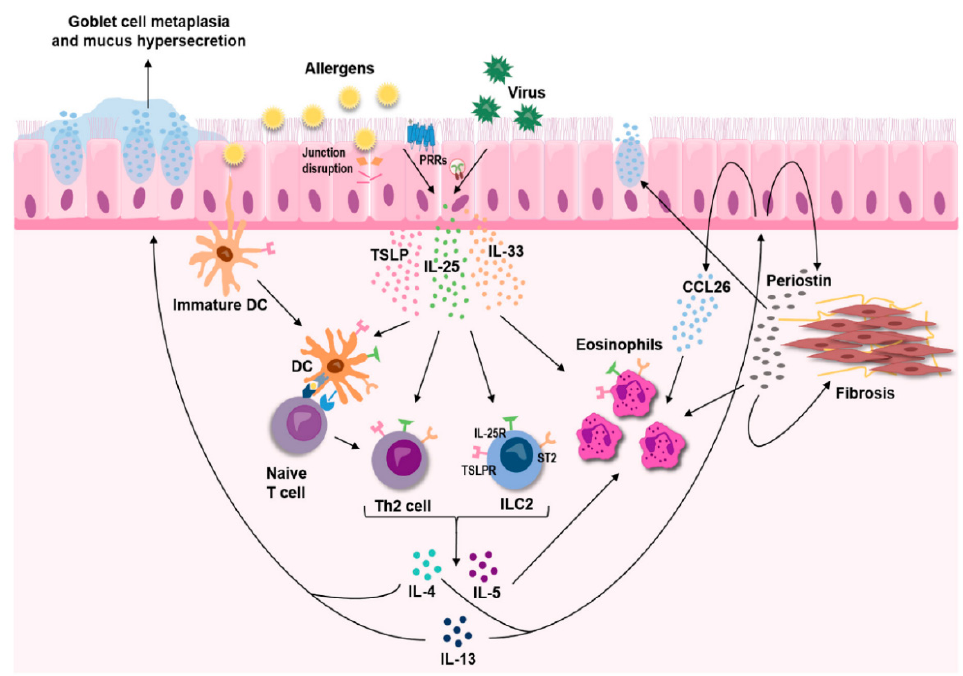
Figure 1. In response to allergens, thymic stromal lymphopoietin (TSLP), interleukin-33 (IL-33), and interleukin-25 (IL-25) cytokines are released that mediate type 2 inflammation in the airways through effects on both innate and adaptive immune cells. Figure adapted from Calven et al.